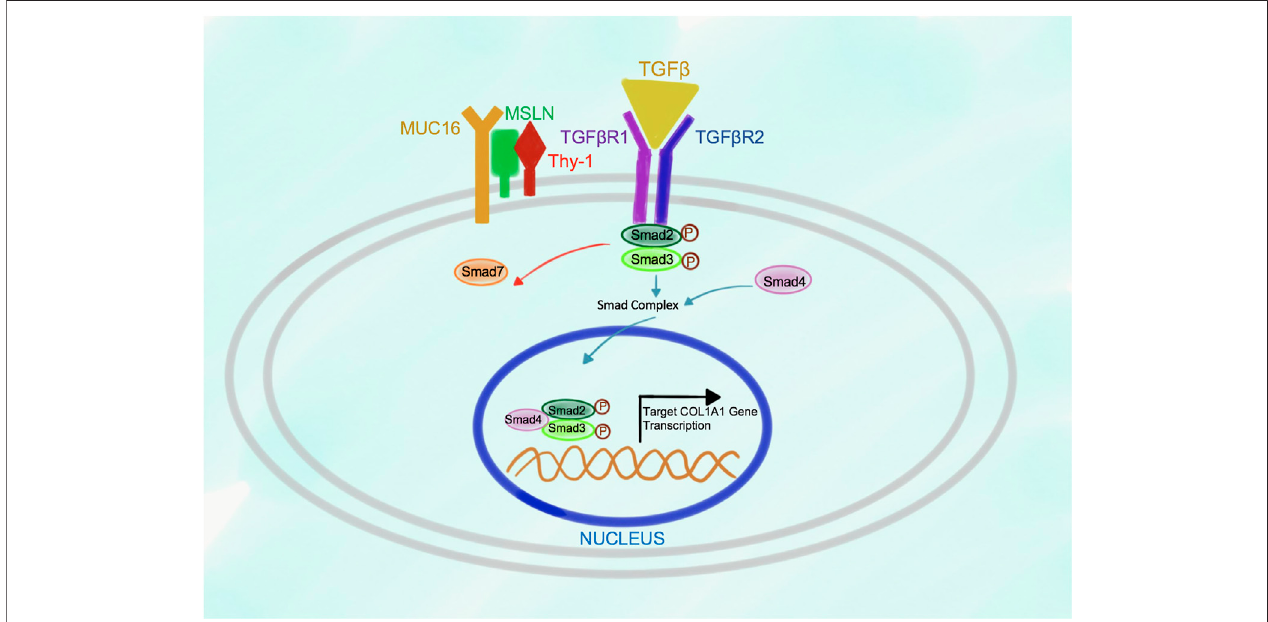
FIGURE 3 | Proposed model of Msln-Muc16-Thy-1 binding in TGF β 1-stimulated wild type aPFs. In response to TGF β 1 signaling Msln-Muc16 complex binds to Thy-1 causing dissociation of Thy-1 from TGF β RI. TGF β 1 binding to TGF β RI and TGF β R2 causes receptor crosslinking, docking of Smad2/3 to the receptors. Upon Smad2/3 phosphorylation, p -Smad2/3 dissociates from the receptors, forms a complex with Smad4, and translocates to the nucleus where it initiates transcription of target genes.